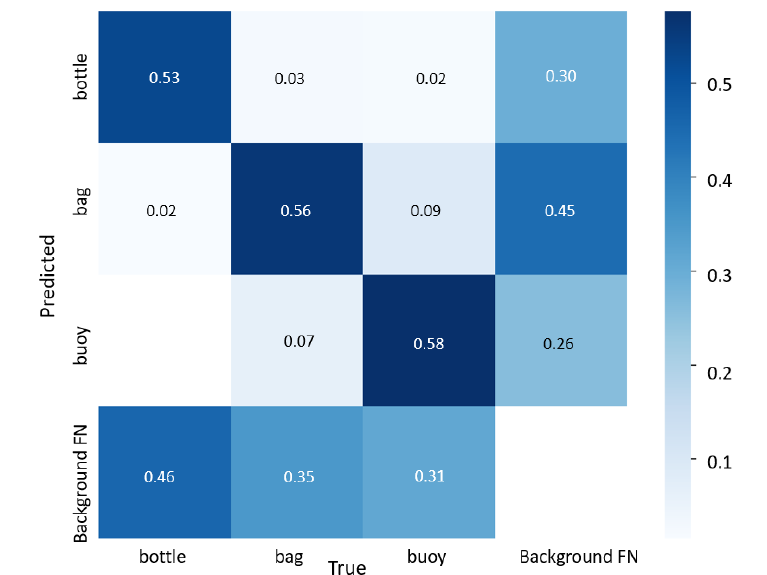
Figure 11. Normalised confusion matrix showing the output from the final model run over the test data set. Bottles were predicted correctly by the model 53% of the time, and bottles were incorrectly identified as background 46% of the time. Bags were correctly identified by the model 56% of the time and wrongly identified as background 35% of the time. Buoys were correctly identified 58% of the time and misidentified as background 31% of the time.